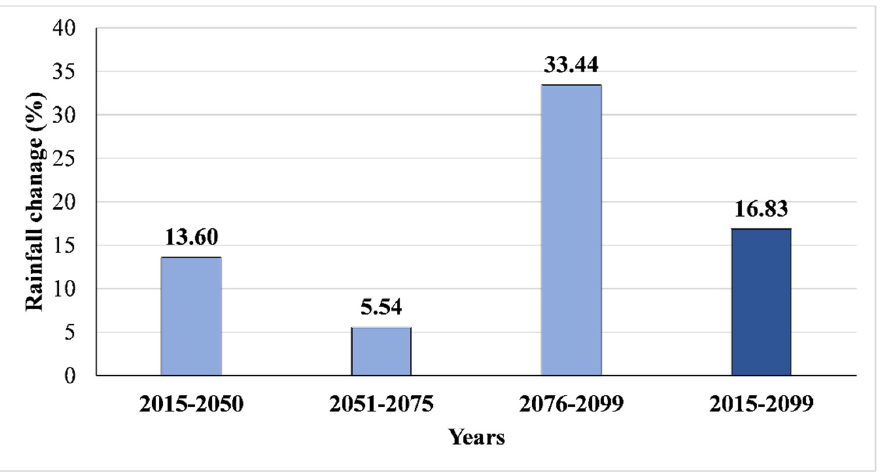
Figure 2. The annual rainfall changes in Egypt between the past period (1950–2014) and the future period (from 2015 to 2099). period (from 2015 to 2099).